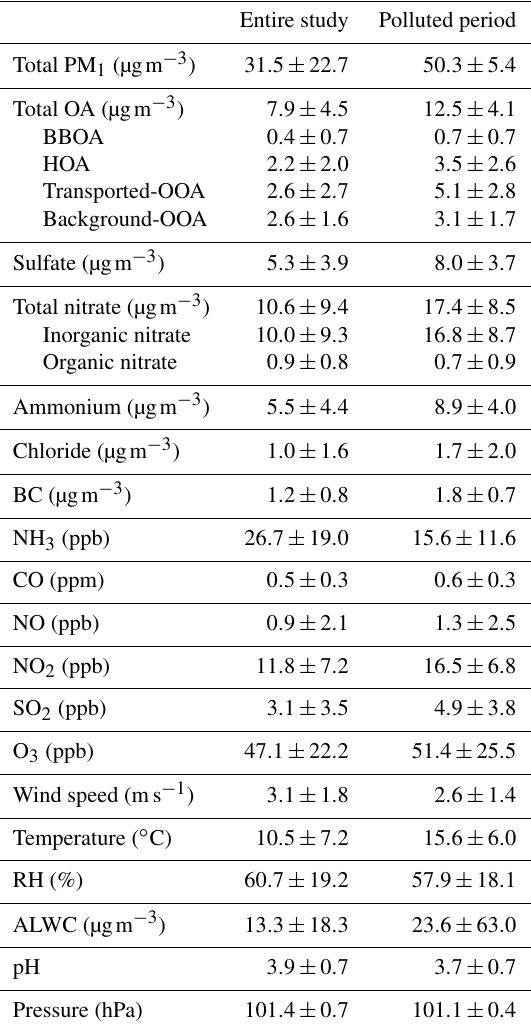
Table 1. Summary of average mass concentrations of PM 1 species and OA factors (µgm − 3 ), average mixing ratios of gas-phase pol- lutants, and values of meteorological parameters during the entire campaign and polluted period. The definition of the polluted period is provided in the caption of Fig.